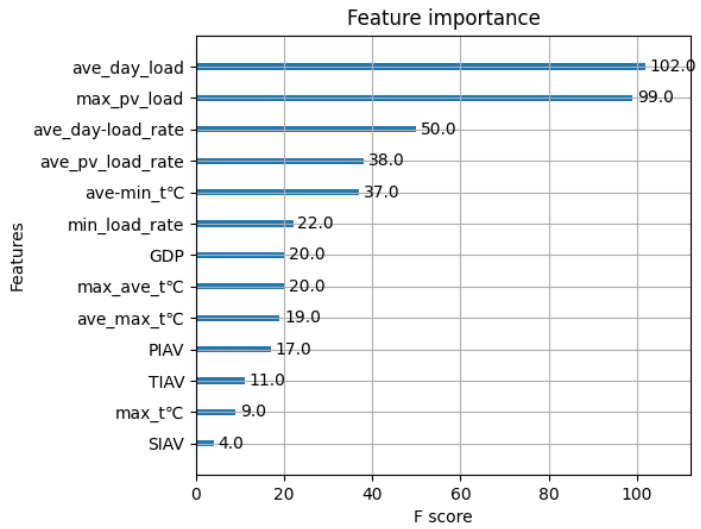
Figure 5. XGBoost feature importance.